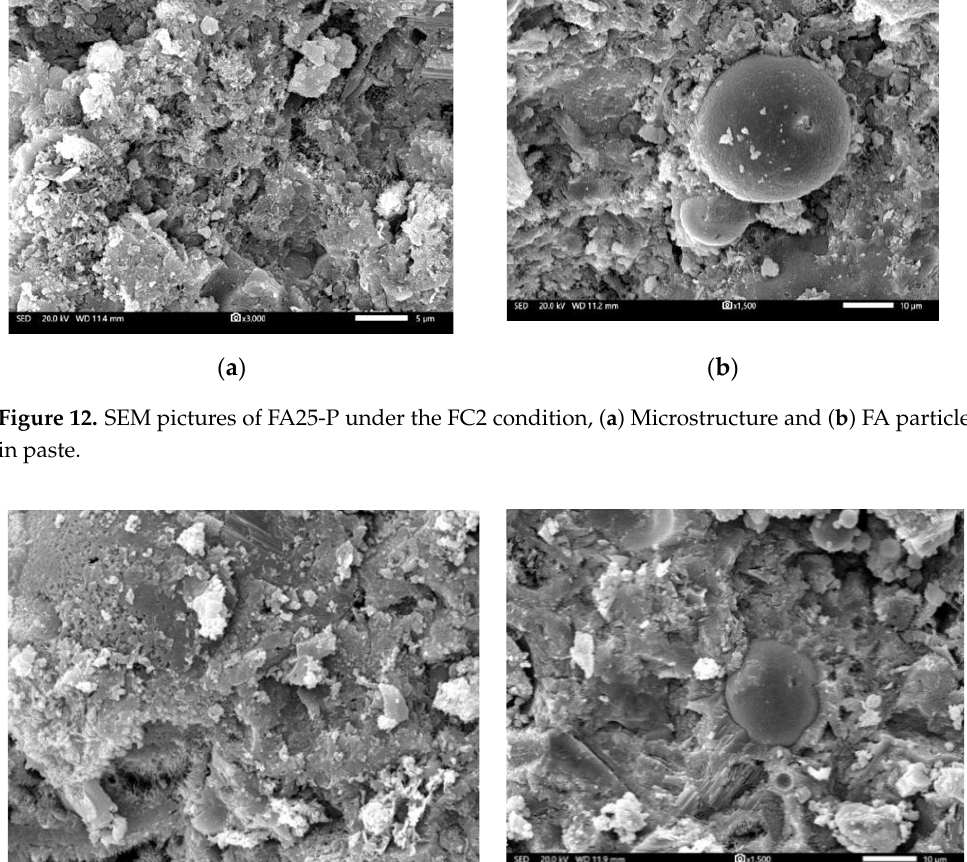
Figure 11. SEM pictures of FA25-P under the FC1 condition, ( a ) Microstructure and ( b ) FA parti- cles in paste.